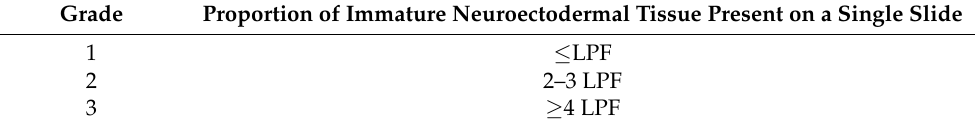
Table 6. Histological grading of an immature teratoma *.